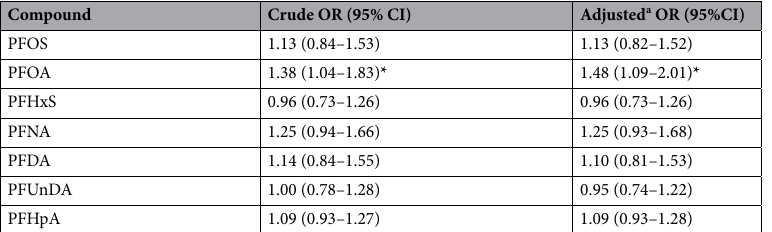
Table 2. Distribution of first trimester serum concentrations (ng/mL) of PFASs. LOD, limit of detection.